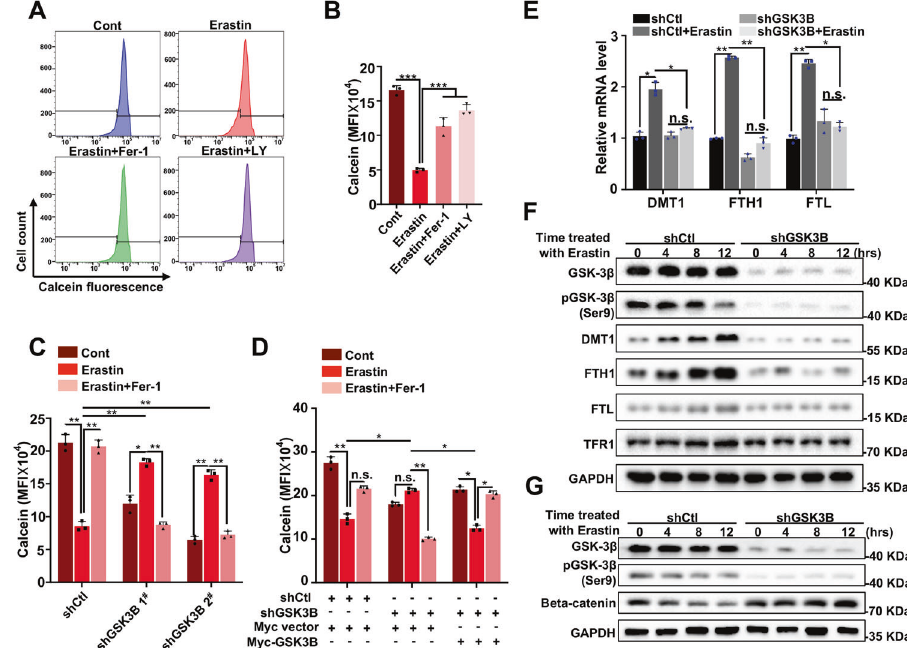
were determined by fl ow cytometry using Calcein-AM probe. B Quanti fi cation of mean fl uorescence intensity (MFI) of calcein from A were shown. Y- axis represents MFI (×10 4 ) and data show the mean ± SD from three independent experiments. C Indicated shCtl, shGSK-3 β 1 #, and 2 # HeLa cells were treated with erastin (35 μ M) with or without Fer-1 (20 μ M) for 24 h, and intracellular labile iron level was assayed by fl ow cytometry using a calcein-AM probe. The mean fl uorescence intensity (MFI) of calcein from each group was quantitated. Y -axis represents MFI (×10 4 ) and data show the mean ± SD from three independent experiments. D Indicated shCtl or shGSK-3 β HeLa cells were transfected with either a control plasmid (myc-vector) or myc-GSK-3 β plasmid. Cells were treated with erastin (35 μ M) with or without Fer-1 (20 μ M) for 24 h, and intracellular labile iron level was assayed by fl ow cytometry using Calcein-AM probe. The mean fl uorescence intensity (MFI) of calcein from each group was quantitated. Y -axis represents MFI (×10 4 ) and data show the mean ± SD from three independent experiments. E Indicated shCtl or shGSK-3 β HeLa cells were treated with erastin (35 μ M) with or without Fer-1 (20 μ M) for 24 h. The mRNA level of DMT1, FTH1, and FTL in indicated cells was assayed by RT-qPCR. The relative gene expression is normalized to GAPDH. Data shown represent